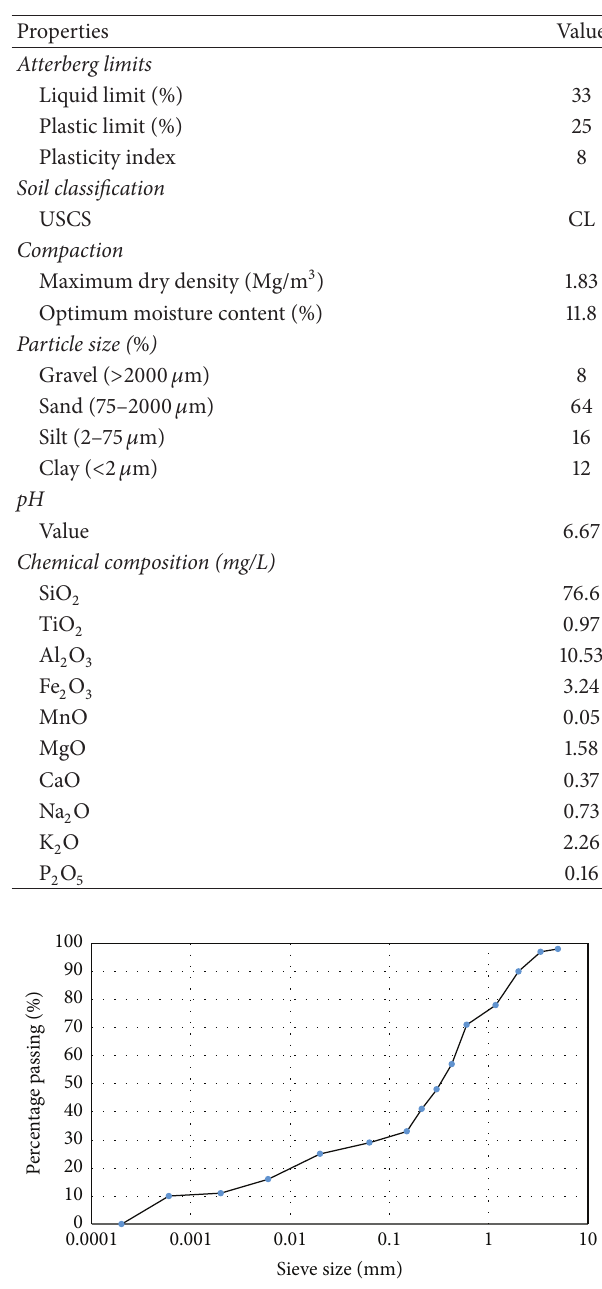
piston presser. The mould of 40 mm internal diameter and 125 mm length cylinder was filled (in three layers) with soil and compressed to a length of 80 mm with Tinius Olsen H50KS (Figure 2(a)) obtained as cylindrical specimen of 40